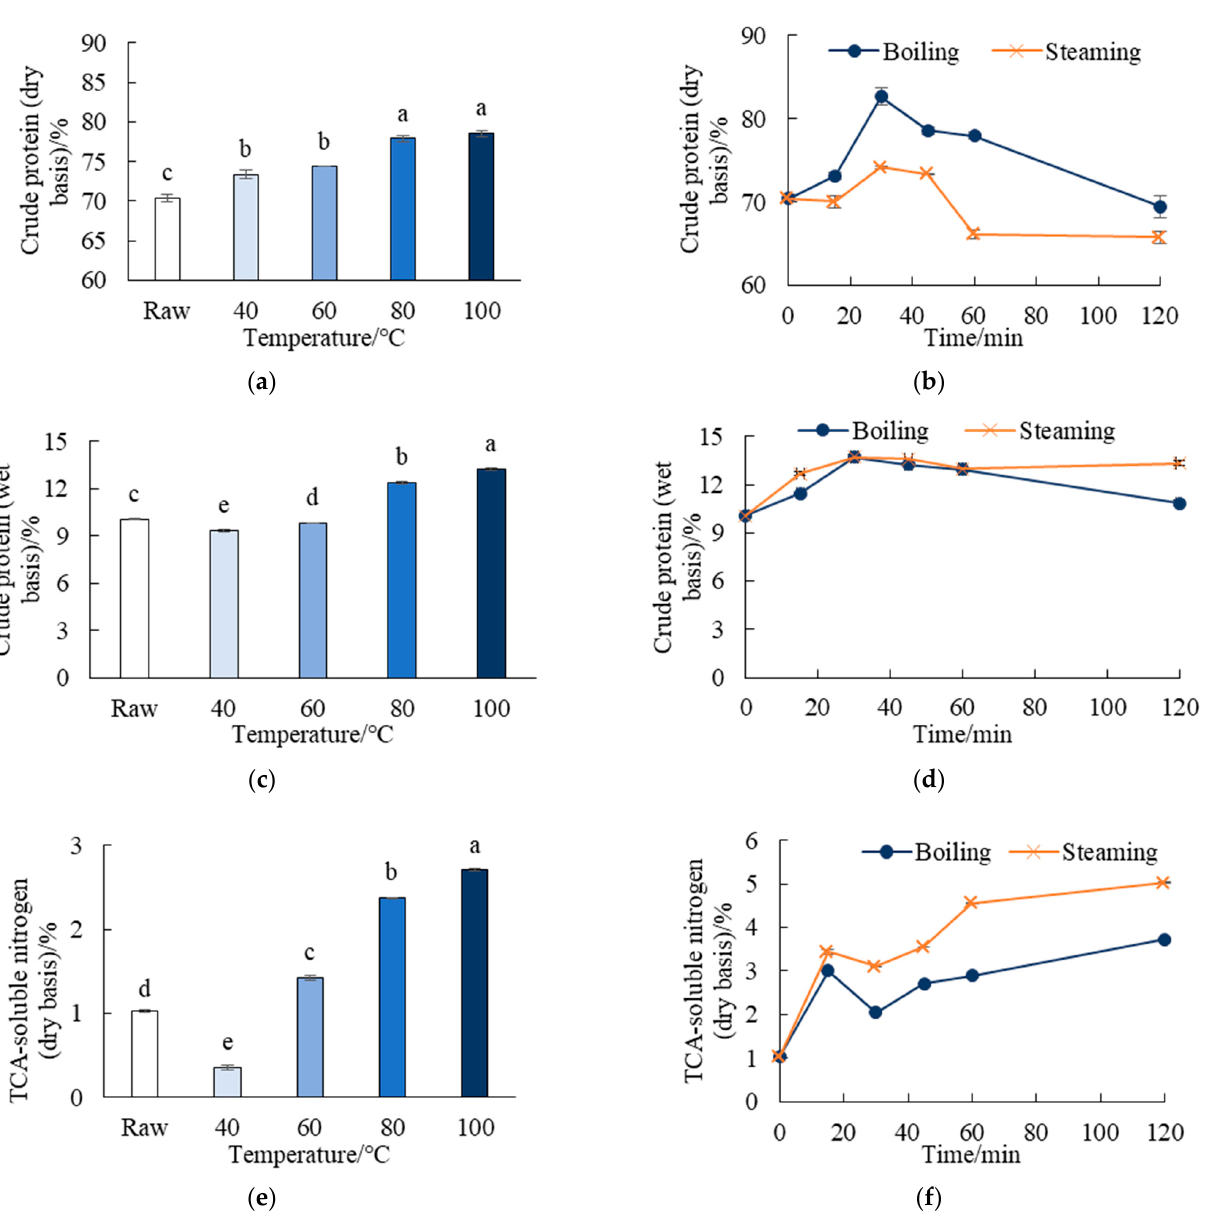
Figure 3. Content of crude protein and TCA-soluble nitrogen of C. frondosa after various heat treatments, comparison of crude protein on dry basis ( a ) crude protein on wet basis ( c ) and TCA-soluble nitrogen ( e ) during cooking for 45 min at different temperatures (40, 60, 80, and 100 ◦ C), and comparison of crude protein on dry basis ( b ) crude protein on wet basis ( d ) and TCA-soluble nitrogen ( f ) after boiling and steaming at 100 ◦ C for 0–120 min. Different letters (a, b, c, d, e) indicate significant differences between groups as determined via one-way ANOVA ( p <